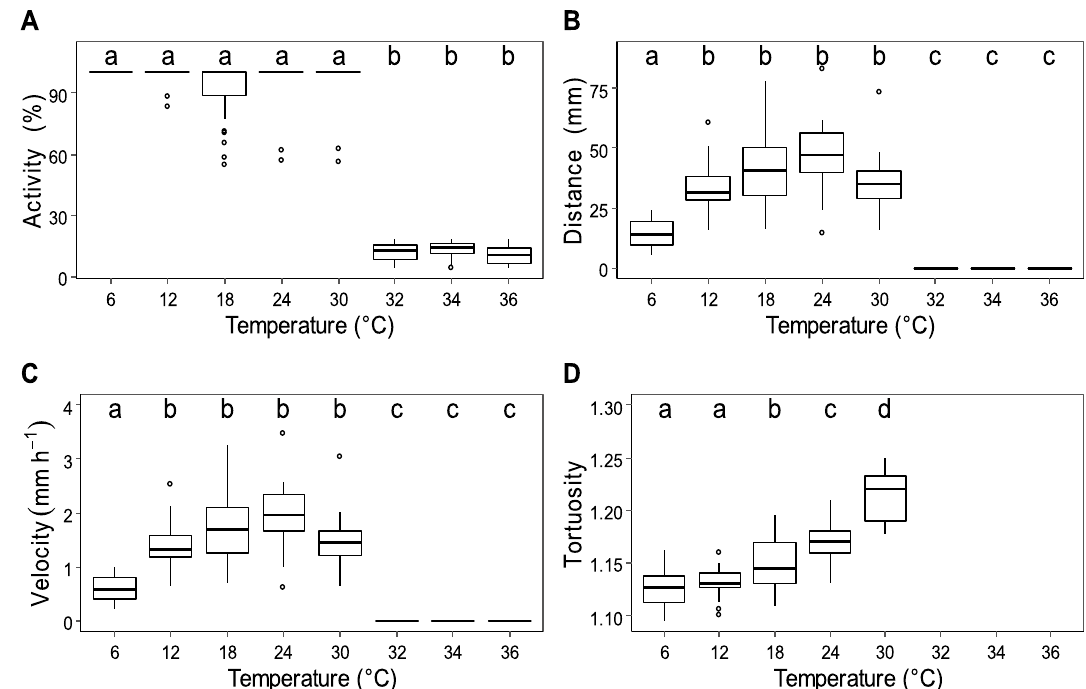
Figure 2. The influence of temperature on ( A ) the activity ( B ) the distance travelled (over 24 h), ( C ) the velocity and ( D ) the fractal dimension of H. germanica . The box represents the first, second and third quartiles and the whiskers extend to 1.5 times the interquartile range; values outside this range are represented by open circles. Number of replicates are 30, 23, 30, 25, 15, 69, 28 and 26 for 6, 12, 18, 24, 30, 32, 34 and 36 °C respectively. Due to the absence of motion it was impossible to estimate fractal dimension at 32, 34 and 36 °C. Letters above the boxes (‘a’, ‘b’, ‘c’ and ‘d’) identify significant different groups (Dunn test, p <